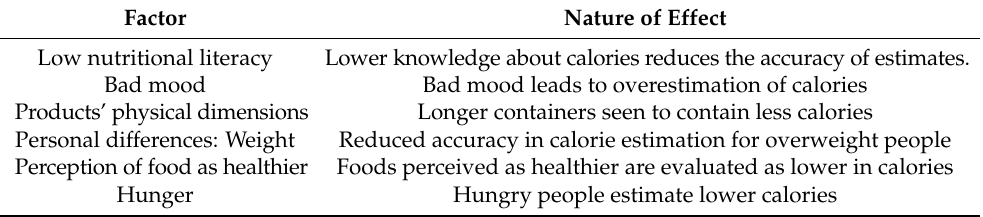
Table 1. Factors affecting calorie